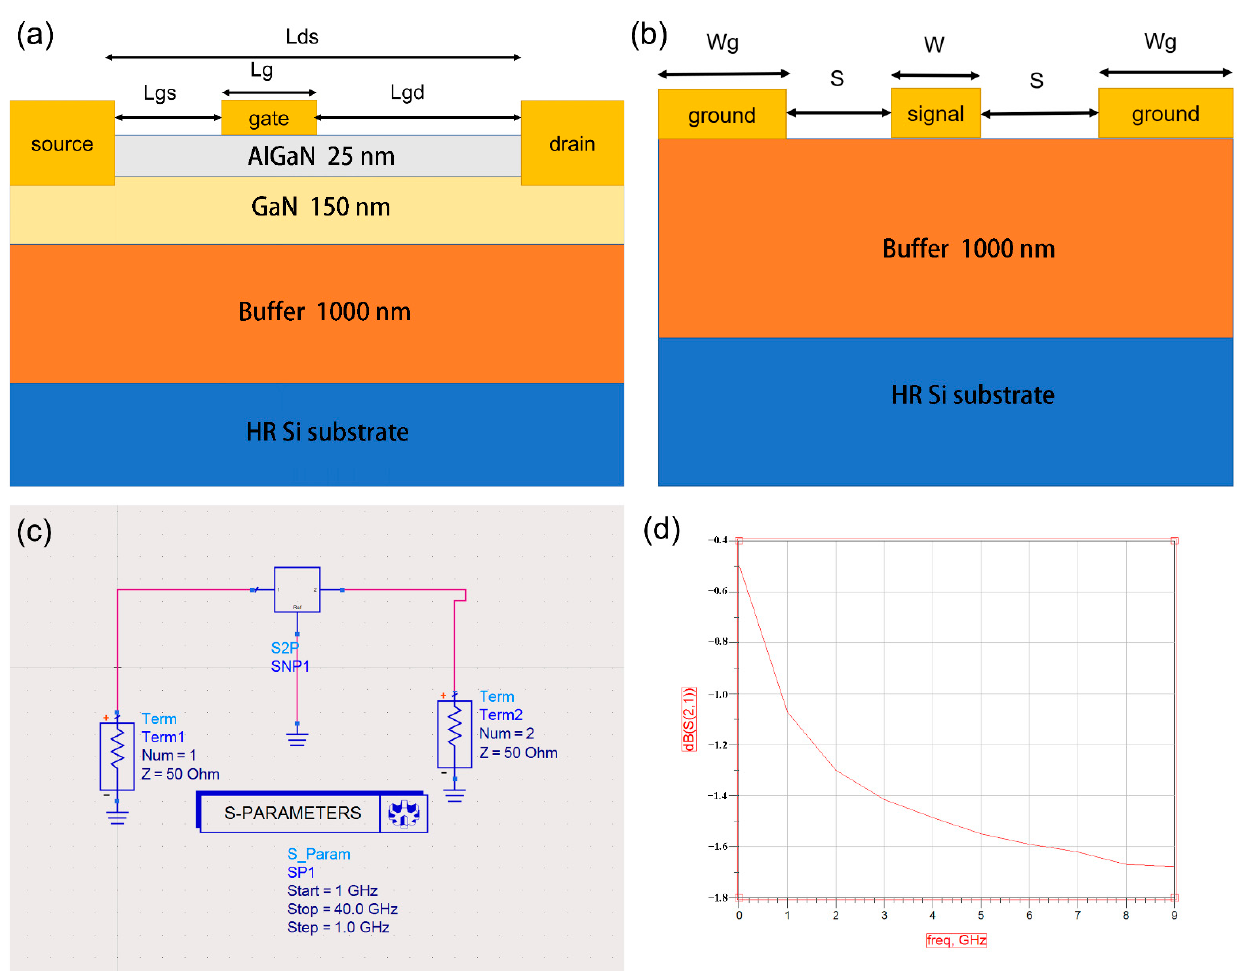
Figure 1. ( a ) The HEMT structure; ( b ) schematic of the CPW structure; ( c ) S-parameter simulation circuit diagram; ( d ) schematic diagram of the S-parameter simulation results.